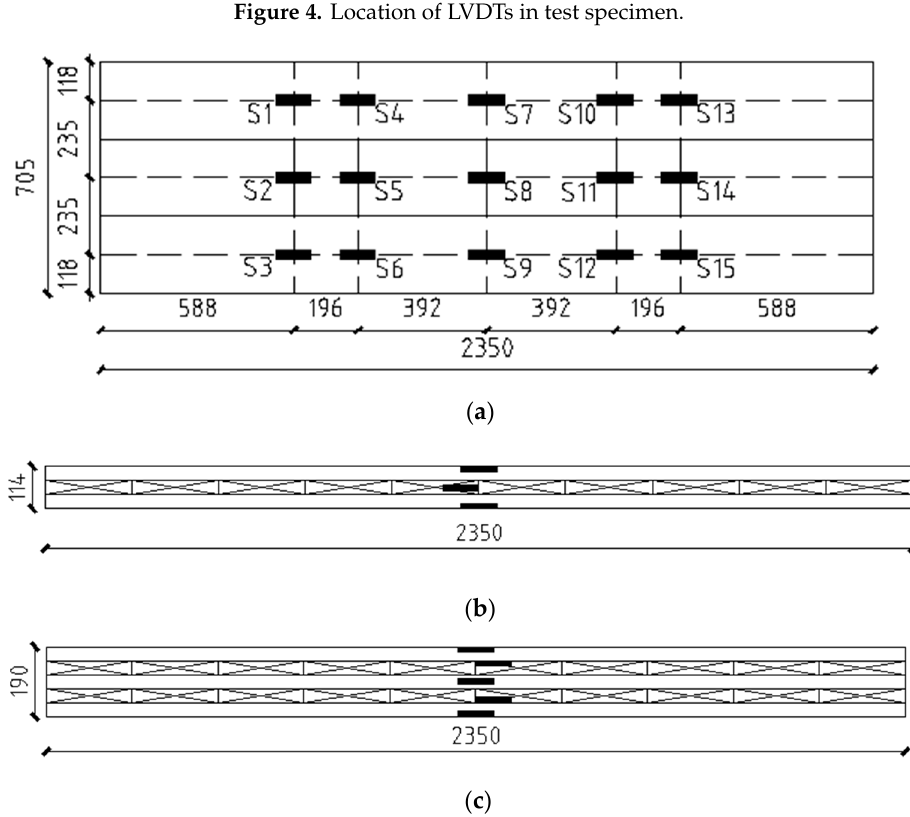
Figure 5. Strain gauge install on nail-cross-laminated timber (NCLT) panels. ( a ) Strain gauge mounted on the lower surface; ( b ) Strain gauge mounted on the side of the 3-layer panel; ( c ) Strain gauge mounted on the side of the 5-layer panel.